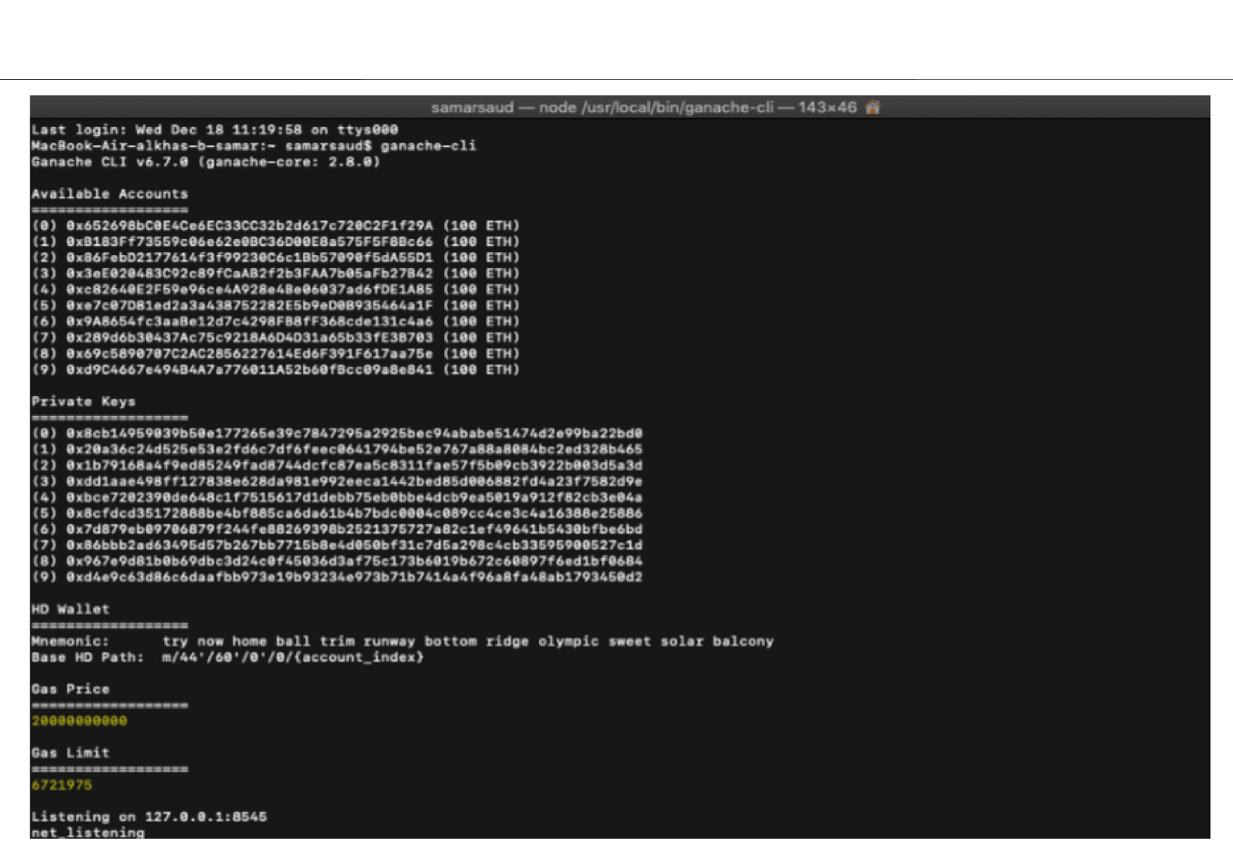
FIGURE 13 | TestRPC (ganache-cli) and 10 accounts.